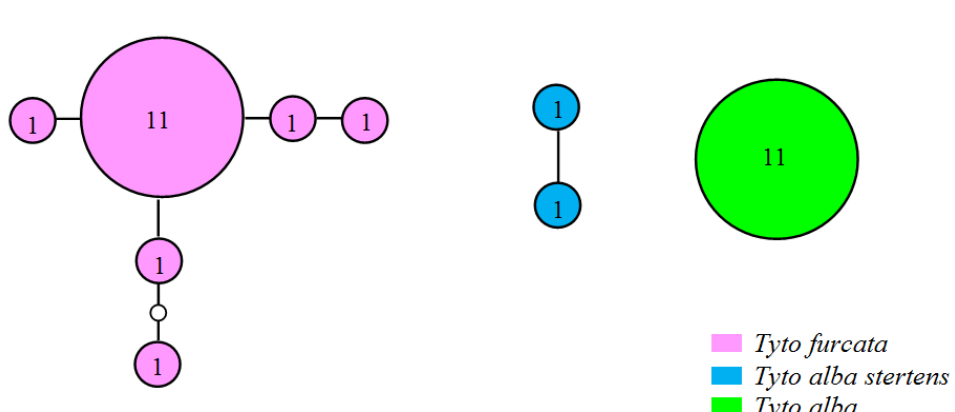
F IGURE 2. Haplotype networks of species of Tyto (30 individuals), based on 620bp of the Mitochondrial cytochrome c oxidase subunit I gene ( CYTB ). The number that was written inside the haplotypes indicated the samples of them. T ABLE 1- Specimen, collection number and GenBank accession numbers for the samples used in the study that were collected all 5 geographical